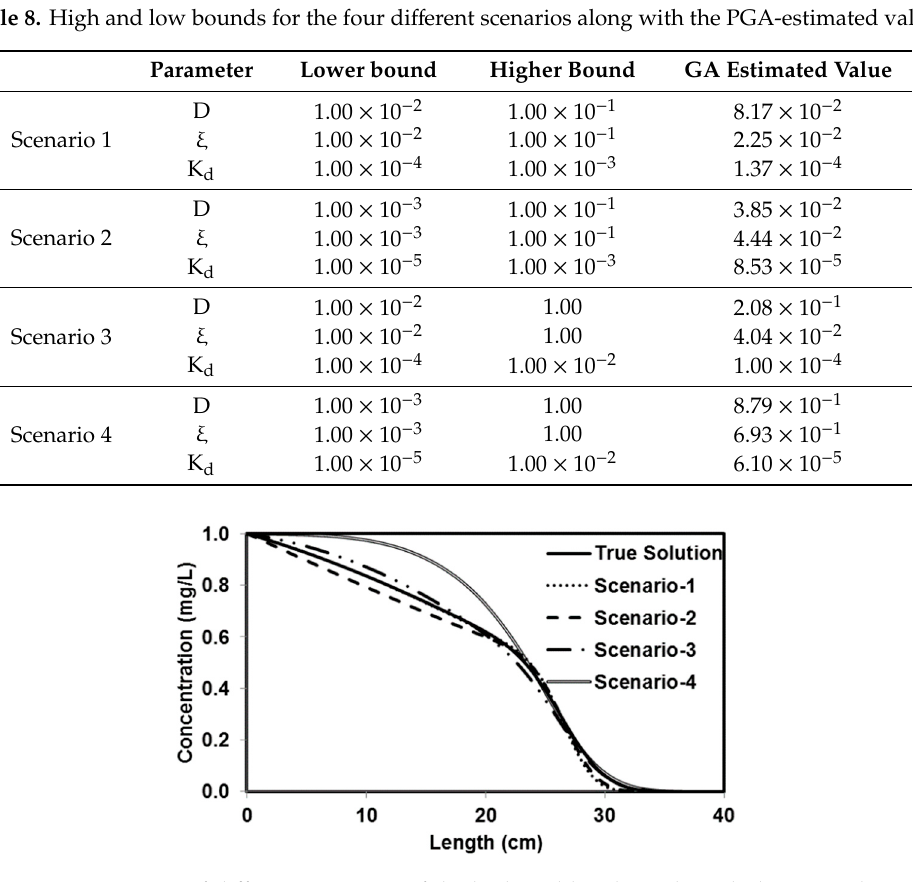
Table 8. High and low bounds for the four different scenarios along with the PGA-estimated value.